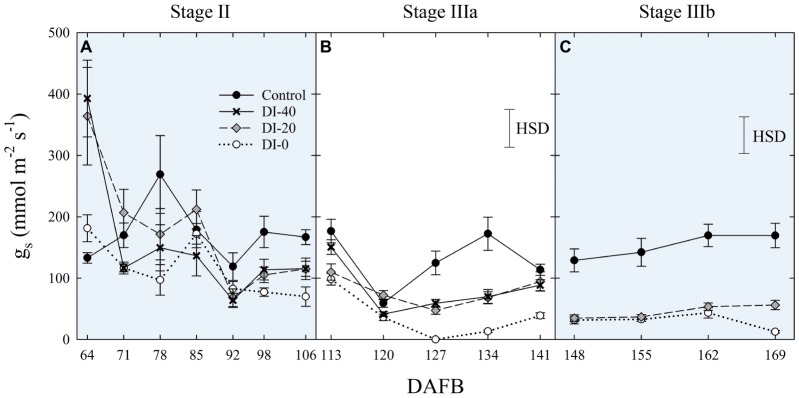
Mid-morning leaf stomatal conductance (gs) at stages II (A), IIIa (B), and IIIb (C) of ‘September Bright’ nectarine fruit growth. Trees irrigated to 100% (control), 40% (DI-40), 20% (DI-20), and 0% (DI-0) of crop evapotranspiration. Timeline expressed in days after full bloom (DAFB). Error bars represent standard errors of means (n = 6). Significant differences determined with analysis of variance and Tukey’s honestly significant difference (HSD, p < 0.05).